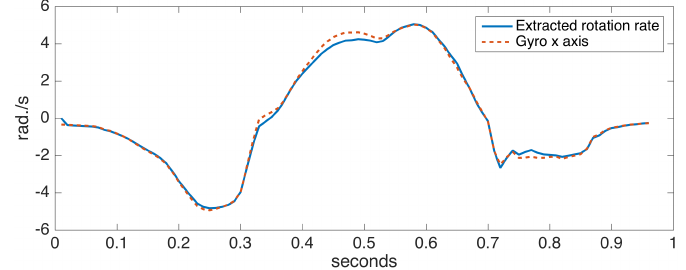
Figure 9. Extracted ankle axis rotation rate vs. gyro x axis of a correctly-positioned